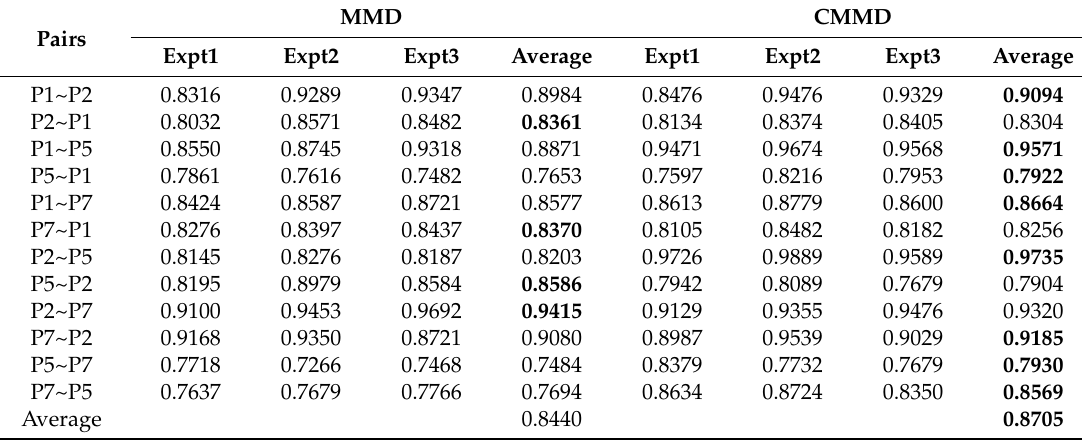
Table 11. The experiments on UCI with the fixed random seed for initialization and the other conditions unchanged as MMD-Small and CMMD-small in Table 10. The bold number in this table means the biggest average in the same row for the two methods with three